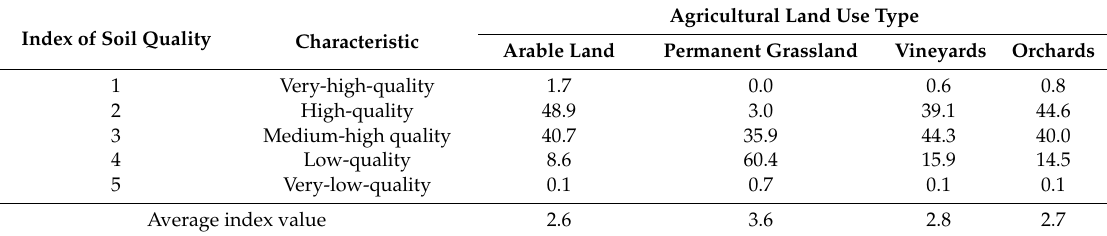
Table 9. Share of soil quality categories (%) in agricultural land use types in